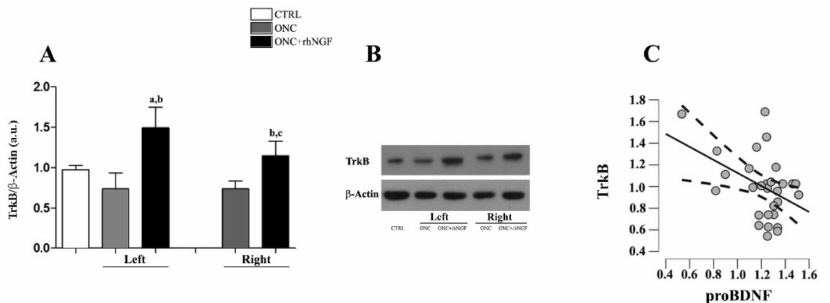
Figure 5. Effects of ONC and treatment with ed-NGF on the expression levels of TrkB in the VCx. WB analysis of TrkB is shown in graph. Data are expressed as mean optical density (arbitrary units, a.u.) and presented as mean ± S.D ( A ). Representative cropped gels showing bands corresponding at the 140 kDa band of TrkB and a loading control ( β -Actin) are presented in ( B ). The graph in ( C ) shows the correlation between the expression levels of proBDNF and TrkB in rat VCx. Statistically different: a vs. CTRL; b vs. ONC; c left vs. right VCx (same treatment condition).